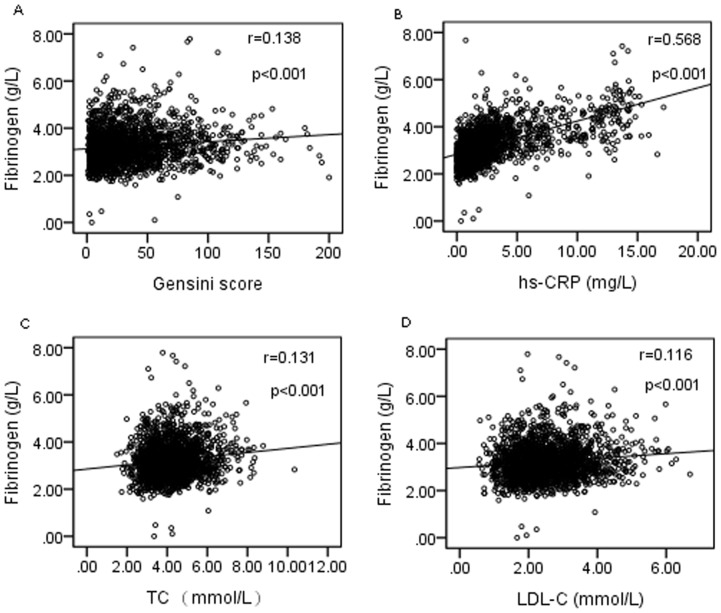
The correlations of fibrinogen level with Gensini score, hs-CRP, TC and LDL-C concentrations in patients with coronary atherosclerosis (A: Gensini score; B: hs-CRP; C: TC; D: LDL-C).hs-CRP =  High sensitivity C-reactive protein; TC =  Total cholesterol; LDL-C =  Low-density lipoprotein -cholesterol.